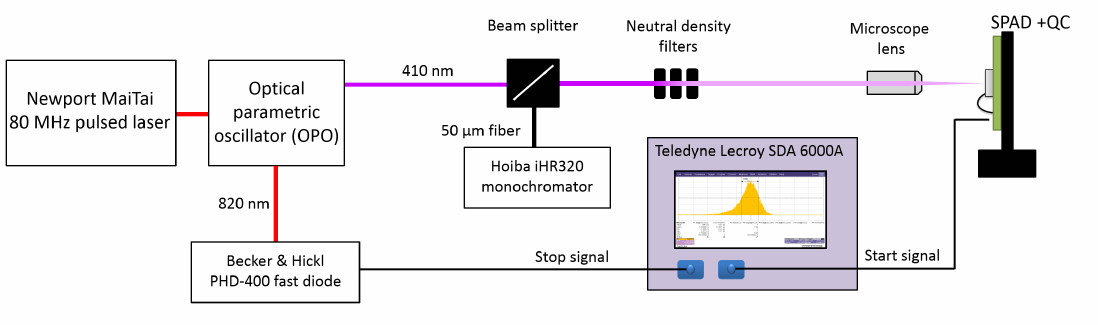
Figure 7. Optical setup used for the single photon timing resolution and the photodetection efficiency measurements of single